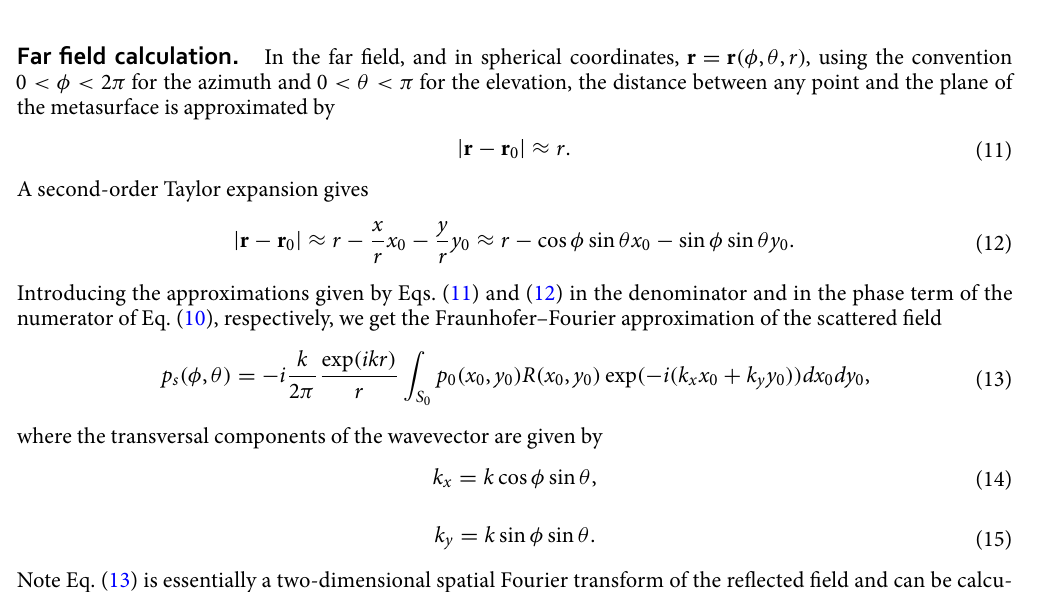
Figure 8. Manufactured spiral metasurface and measurement